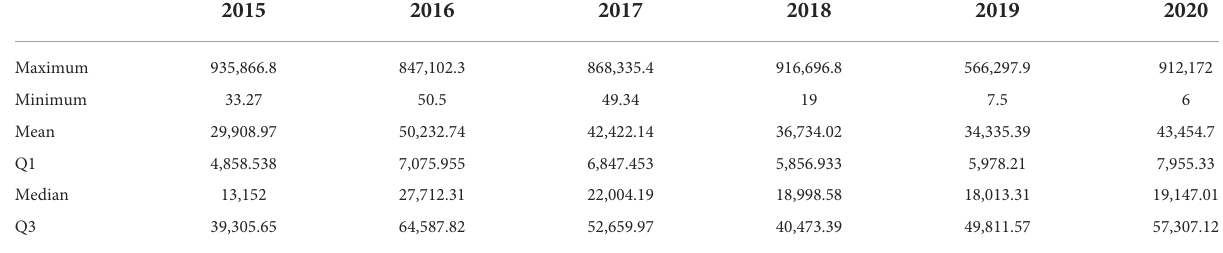
TABLE 1 The healthcare expenditure arising from RTIs in Jilin Province from 2015 to 2020.